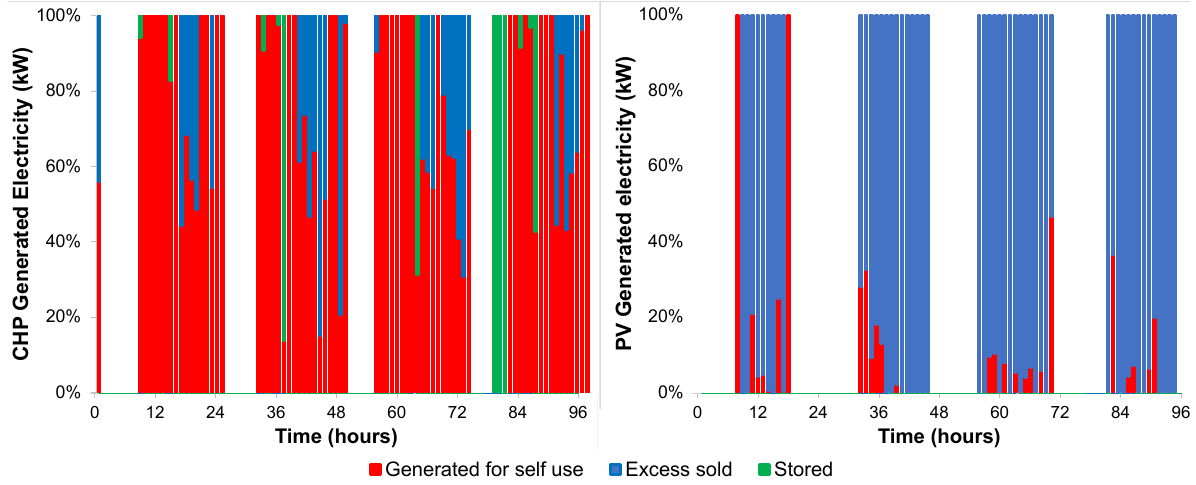
Figure 3. Operation of the CHP and PV unit, respectively, over the 4-day time horizon for household i1.